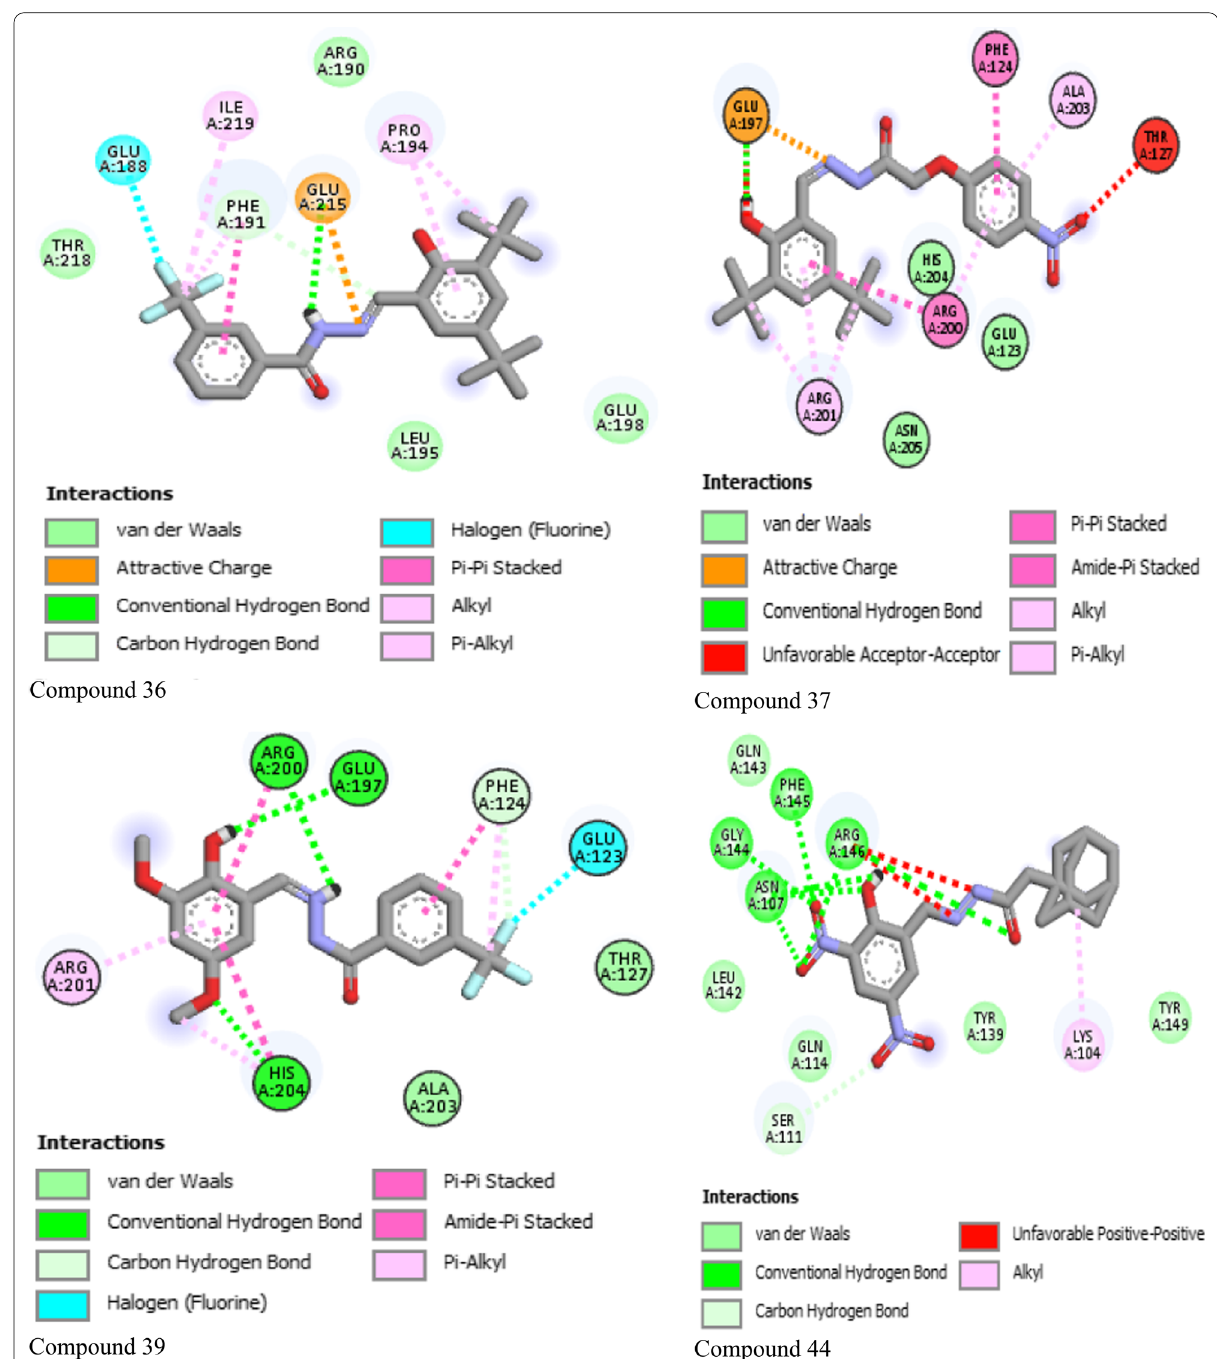
Fig. 6 Docking pose of the ligands into the active site of IncA membranes